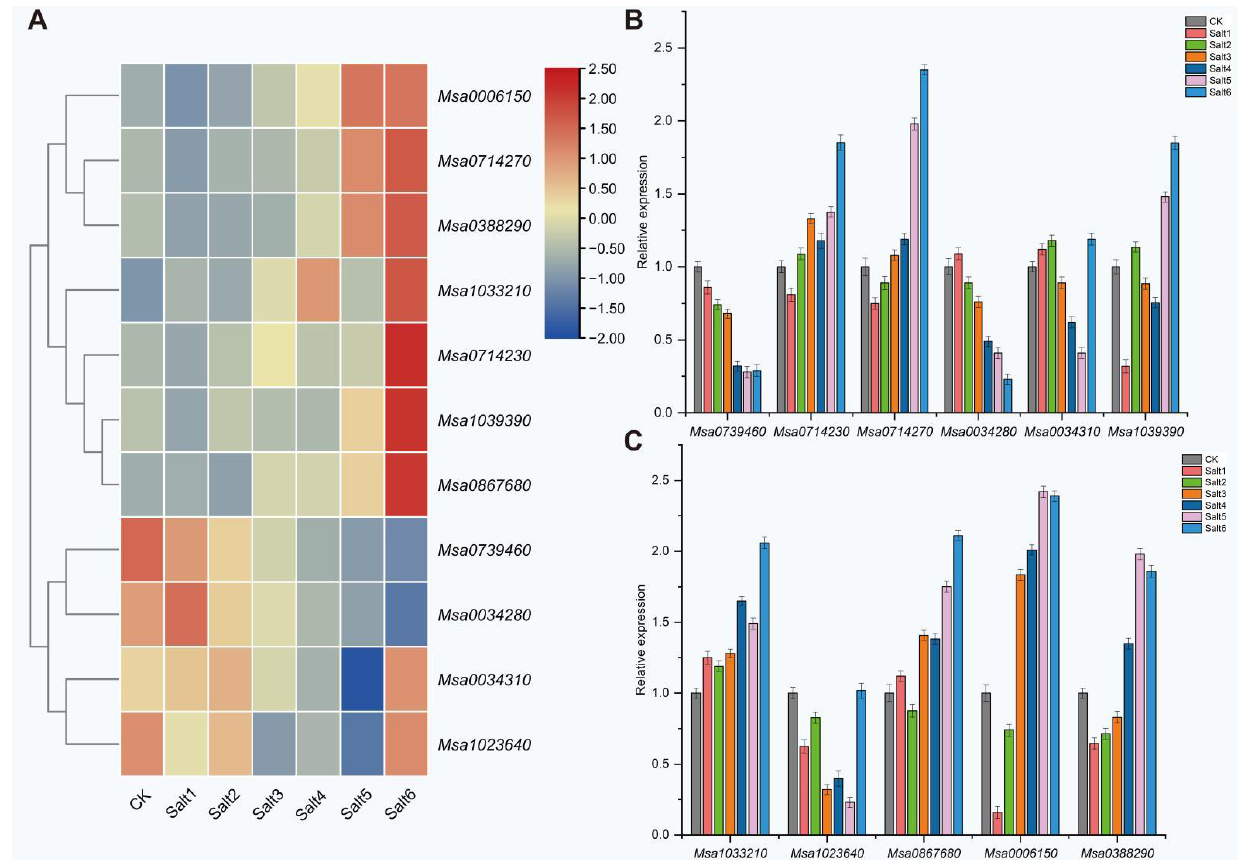
Figure 5. ( A ) Heatmap of the 11 DEGs that responded to salt stress. The expression levels were normalized by row using the Z-scores algorithm. The color scale on the right of the heatmap refers to the relative expression level, and the color gradient from blue to red presents an increasing expression level. ( B ) RT-qPCR analysis of Msa0739460 , Msa0714230 , Msa0714270 , Msa0034280 , Msa0034310 , and Msa1039390 . ( C ) RT-qPCR of Msa1033210 , Msa1023640 , Msa0867680 , Msa0006150 , and Msa0388290 . CK was arbitrarily set to 1. Error bars represent the standard deviations of three technical replicates.